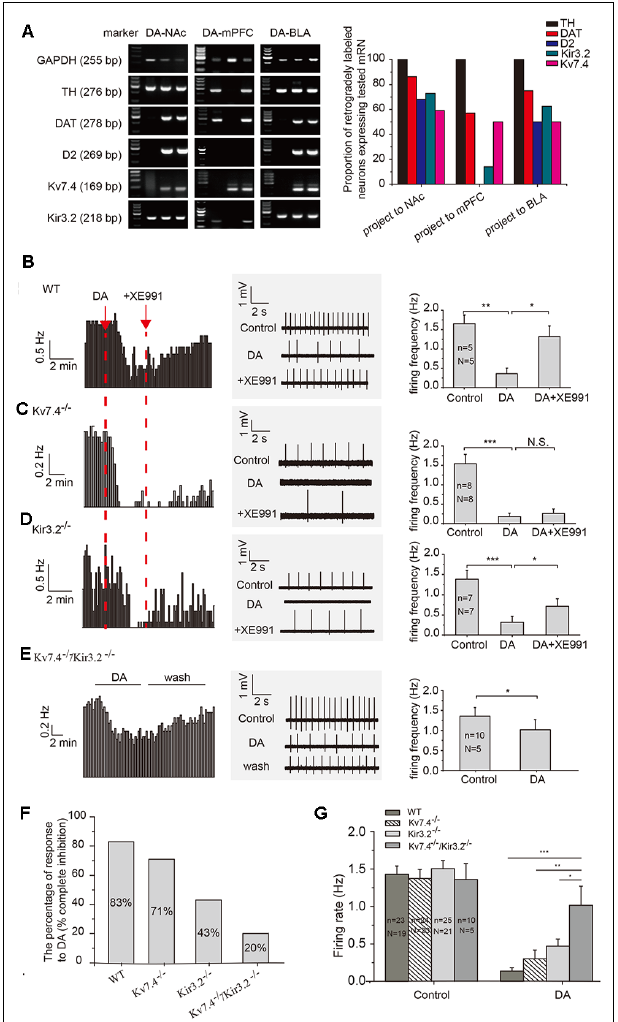
FIGURE 1 | Kv7.4 contribute to the dopamine (DA)-induced inhibition of NAc-projecting DA neuron firing. (A) Single-cell polymerase chain reaction (PCR) analysis in retrogradely labeled ventral tegmental area (VTA) DA neurons from different projections. (B–D) VTA DA neuron firing recorded with loose cell-attached patch recordings. XE991 (3 µ M), a Kv7 blocker, reversed the DA-induced inhibition of neuron firing in WT (B) and Kir3.2 − / − (D) mice, but not in Kv7.4 − / − mice (C) . (E) The effect of DA on spontaneous firing in DA neurons from Kv7.4 − / − /Kir3.2 − / − mice. (F) The percentage of VTA-NAc DA neurons with firing rate being inhibited to less than 20% (complete inhibition) in WT, Kv7.4 − / − , Kir3.2 − / − and Kv7.4 − / − /Kir3.2 − / − mice. (G) Average DA inhibition on firing rate in all recorded VTA-NAc DA neurons from WT, Kv7.4 − / − , Kir3.2 − / − and Kv7.4 − / − /Kir3.2 − / − mice. One-way repeated-measures ANOVA with Bonferroni post hoc test. ∗∗∗ p < 0.001, ∗∗ p < 0.01, ∗ p < 0.05; N.S., not significant. One-way repeated-measures ANOVA with Bonferroni post hoc test. N , number of animals; n , number of recordings.